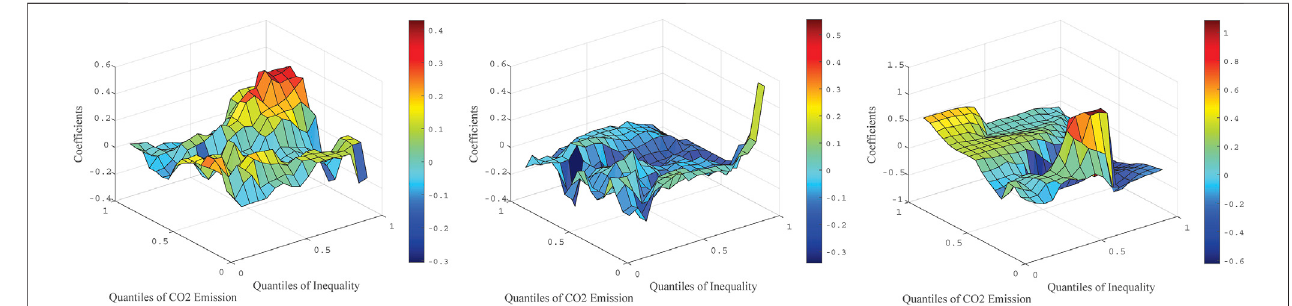
FIGURE 8 | The impact of carbon emission on income inequality in the short, medium and long term (France).